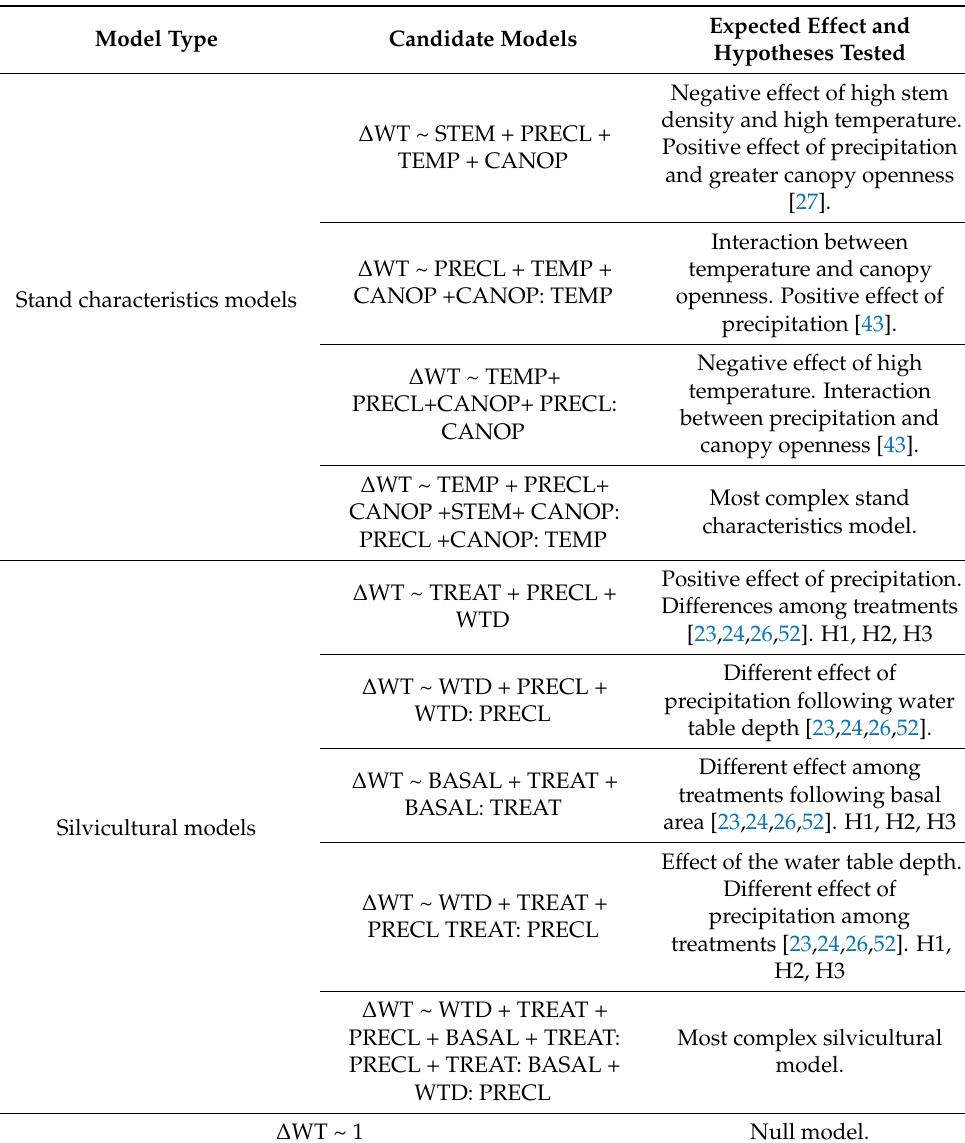
Table 3. List of candidate models explaining daily variation of water table depth between consecutive days ( ∆ WT ) before and after treatments in 2016 and 2017, during the growing season (May to September). Each model type is based upon either stand characteristics or silvicultural treatment effects. Candidate variables included temperature (TEMP), canopy openness (CANOP), standardized precipitation that was lagged by one day (PRECL), stem ha − 1 (STEM), silvicultural treatments (TREAT) with three different levels (control, partial harvest, girdling), basal area (BASAL), and water table depths (WTD). The third column is the expected effect on ∆ WT , the hypotheses tested and the associated